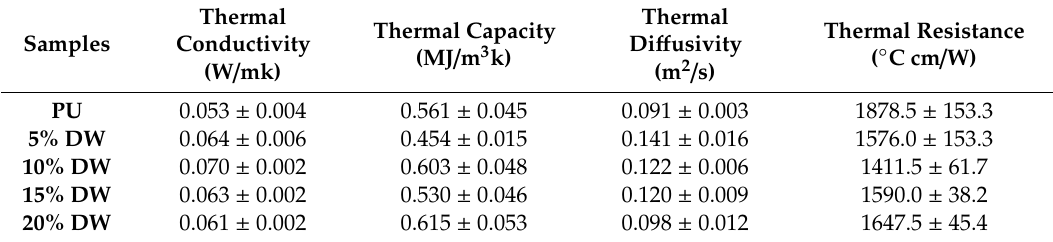
Table 2. Main thermal properties of pristine PU and the eco-composites ( n = 3, S.D. ±